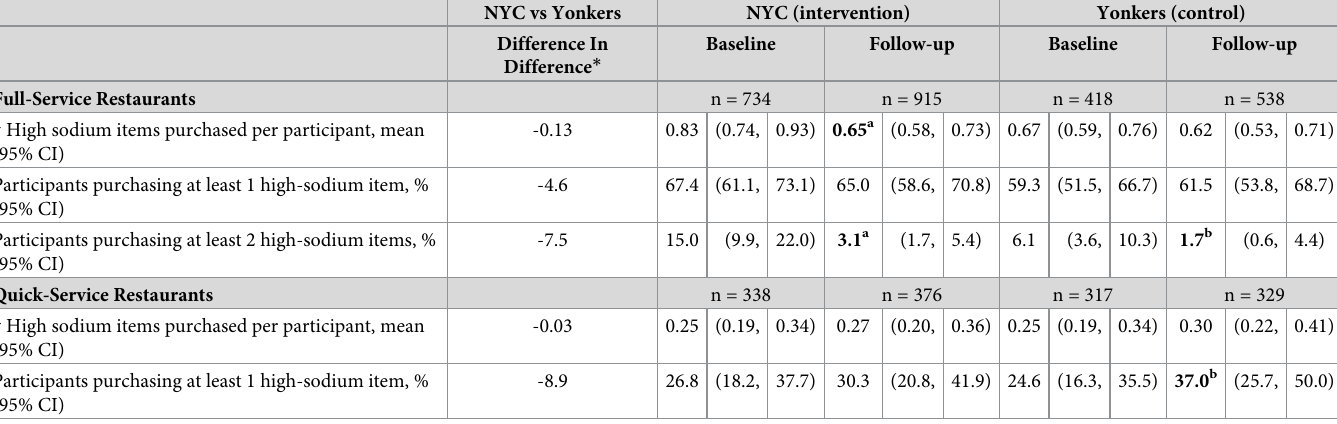
Table 3. High-sodium dinnertime purchases at full-service and lunchtime purchases at quick-service restaurant chains, pre- (baseline) and post- (follow-up) imple- mentation of the sodium warning icon in